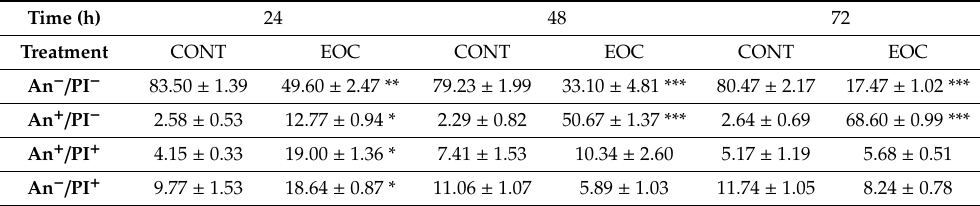
Table 6. Induction of apoptosis in MCF-7 cells after EOC treatment.